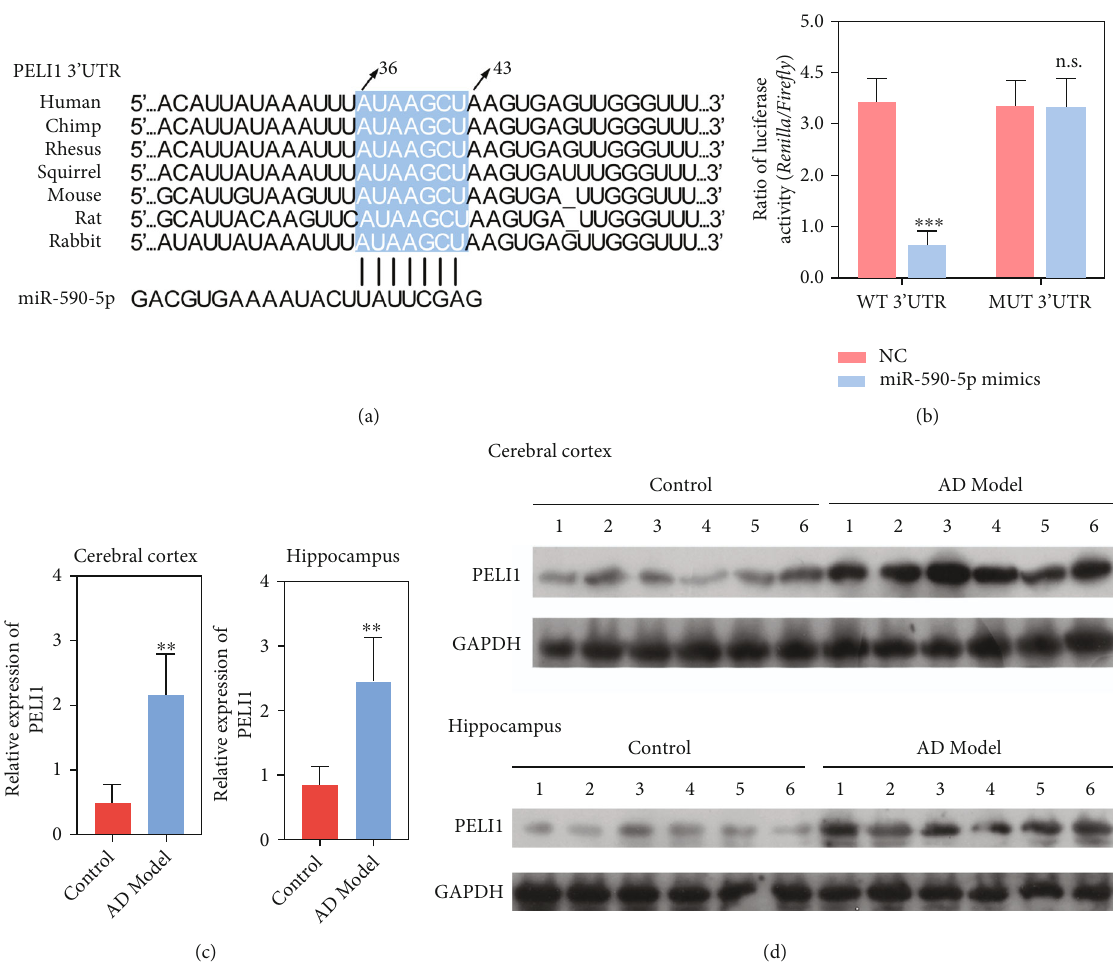
Figure 2: PELI1 was identi fi ed as a target gene of miR-590-5p. (a) Prediction of the binding site of miR-590-5p and PELI1 by the TargetScan and Starbase databases. (b) Identi fi cation of target regulation of miR-590-5p and PELI1 proved by luciferase reporter system. (c, d) The mRNA and protein levels of PELI1 in the cerebral cortex and hippocampal tissue from wild-type mice (control) and APP/PS1 transgenic mice (AD model) by qPCR and western blotting. Each experiment was repeated three times. ∗∗ P < 0 : 01 vs. control